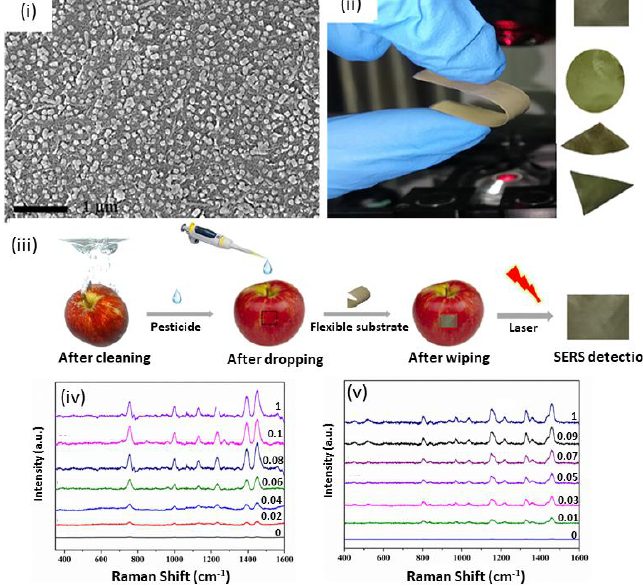
Figure 5. SEM images of CNC-S70/Au–Ag NCs prepared via self-assembly of gold nanoflowers (AuNFs) and silver-coated gold nanocubes (Au@AgNCs) on nanocrystalline cellulose (CNC) films (i)